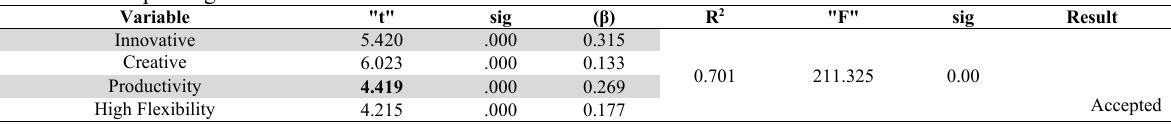
Result of Multiple Regressions test